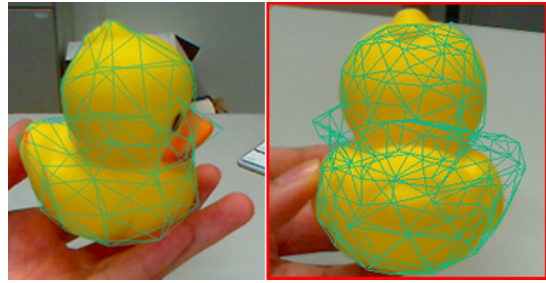
Fig. 19. Highlighted by the red square, a pose incorrectly handled by our